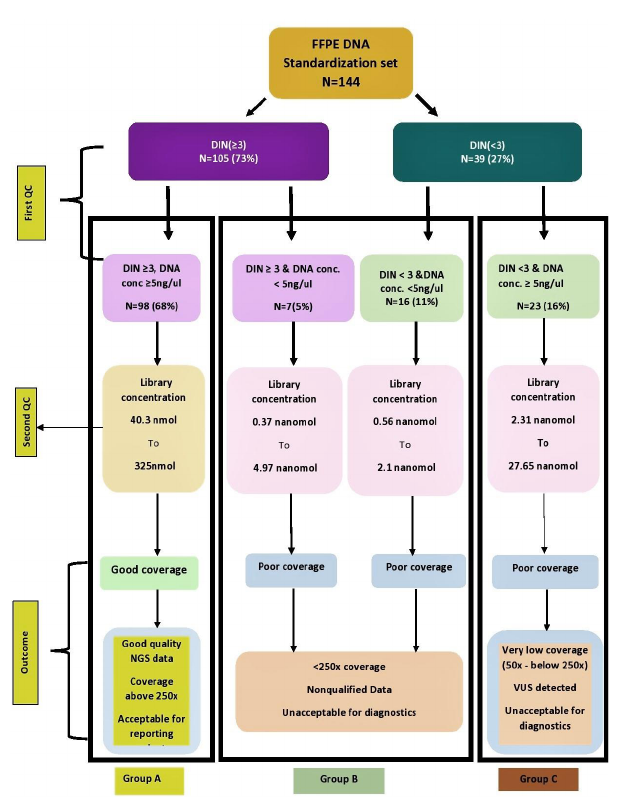
Figure 7. Decision tree for FFPE DNA. This figure describes the decision tree based on the pre- analytical and post-analytical parameters observed in 144 DNA samples. DIN, DNA concentration, and library concentration are found to be the predictive parameters while implementing targeted NGS in diagnostic settings. The first QC checkpoint is at the preanalytical phase consisting of DIN and DNA concentration. The second QC is at the library concentration of DNA samples. Implementing both QC checks can predict the outcome of FFPE DNA-based NGS for a targeted panel in a diagnostics